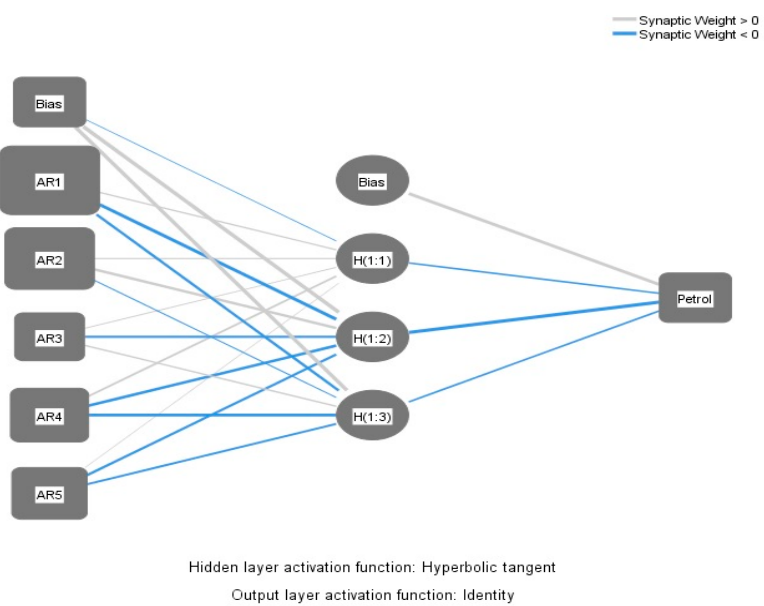
Figure 8. ANN model for household gas consumption.